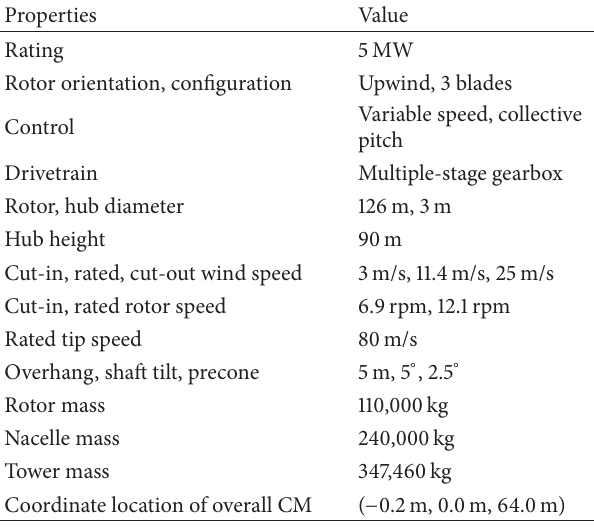
Table 1: NREL 5 MW wind turbine model properties.